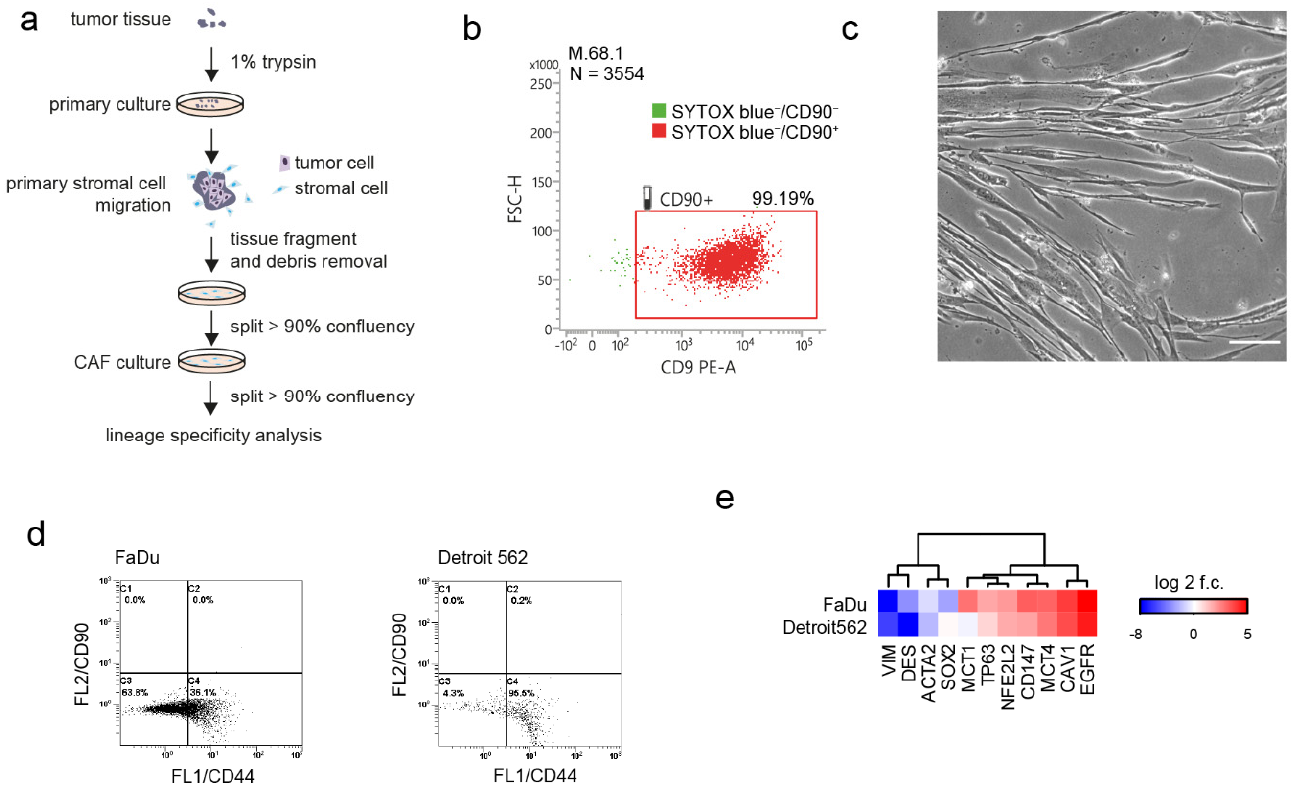
Figure 1. Lineage specificity of cancer-associated fibroblast (CAF) culture and cancer cells. ( a ) sche- matic of stromal cell isolation from tumour tissue fragments. ( b ) CD90 lineage specificity of CAF culture, positivity shown for viable = SYTOX™ Blue-negative cell subpopulation (SYTOX™ Blue stains dead cells with compromised plasma membranes but will not cross intact cell membranes), for more cases see Figure S1. ( c ) morphology of CAFs, scalebar indicate 10 μ m. ( d ) CD44/CD90 sta- tus of FaDu and Detroit 562 head and neck cancer cell lines. ( e ) mRNA subtype-relevant genes, mean expression in FaDu and Detroit 562 cancer cell